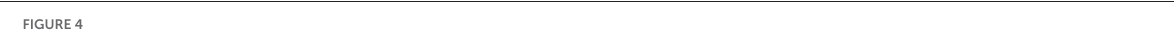
FIGURE4 microscopy. Transformed cells show both a red ER-localized signal and a green nucleo-cytoplasmic-localized Avr2-NG, Six6-NG, or Six8-NG signal (indicated by arrowheads). The scale bar represents 50 µ M. (D–F) Approximately, 20 individual images based on two independent biological replicates were analyzed to provide quantification of cell-to-cell movement of, respectively, Avr2-NG, Six6-NG, and Six8-NG. Each data point represents a single image of a transformation border where the number of cell-to-cell movement events (i.e., number of cells) was